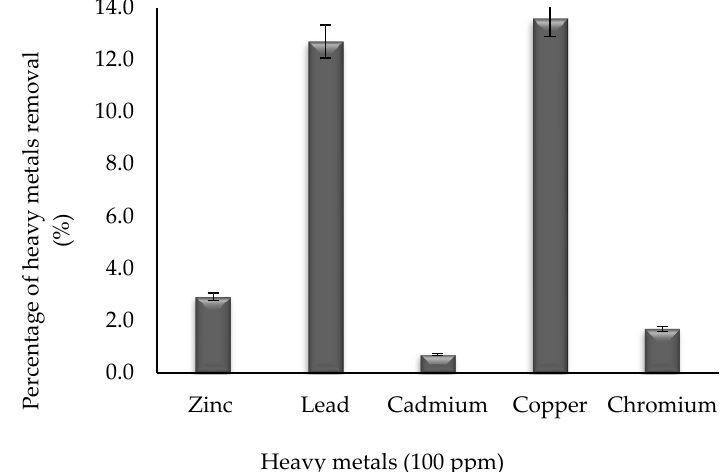
Figure 4. Heavy metals removal using surfactin produced from Bacillus sp. HIP3 after treatment for 24 h.